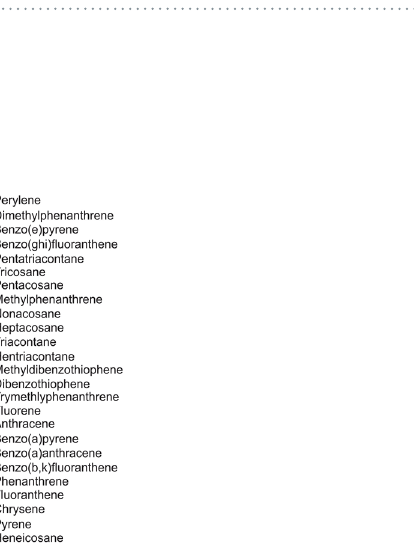
Table 1. Paired t-test treatment versus control for the different experiments and exposure times. Significant results (p < 0.05) are marked w ith asterisk * .